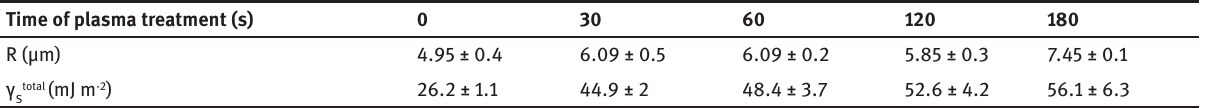
Table 1: Effect of air-plasma treatment on the wickability of the linen fabrics. Changes in apparent capillary radius (R) and surface free energy (γ stotal ) as a function of time of plasma treatment.